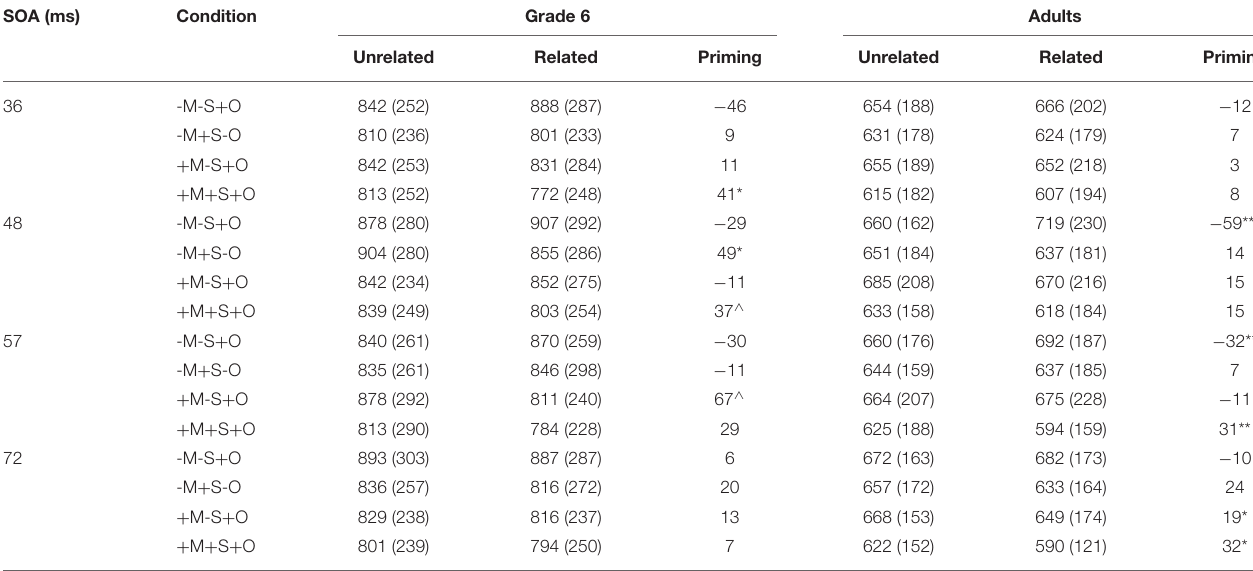
TABLE 3 | Mean RT (ms) and standard deviation of Grade 6 children and adults across the four experiments.